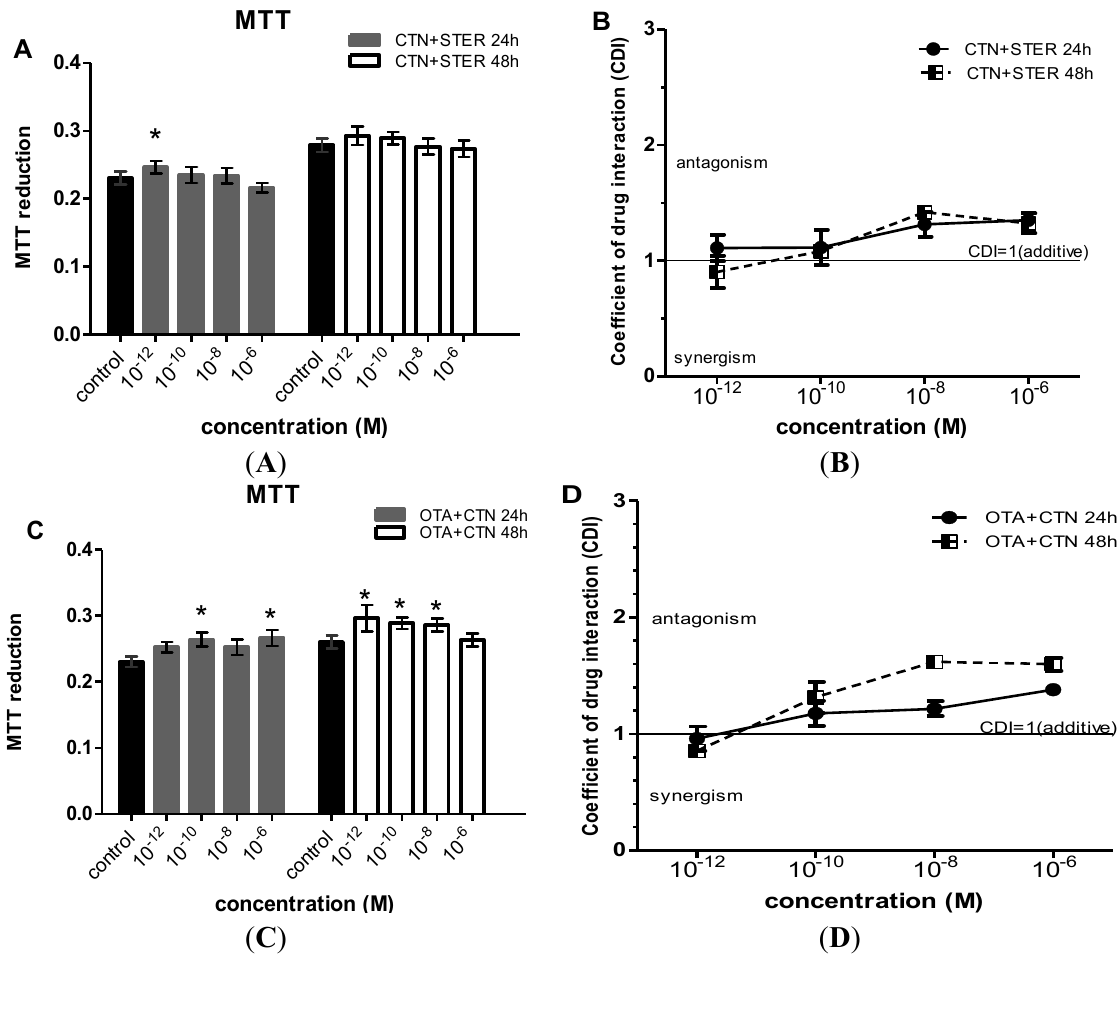
Figure. 2. Evaluation of MTT activity in Hep3B cells after co-administration of ( A ) CTN and STER ( C ) OTA and CTN ( E ) STER and OTΑ for 24 and 48h; Bars represent mean values of every concentration at each time point, which was evaluated at three individual experiments, performing measurements at a number of 8-plicates each time (8-plicates, n = 3). Error bars give the standard error (SE) between the replicates (n = 3). The asterisks represent statistically significant differences over the respective vehicle-receiving cells (control) (* p < 0.01). CDI values (CDI = 1 CDI<1 and CDI>1, shows additive, synergic and antagonistic action respectively) after co-administration of ( B ) CTN and STER ( D ) CTN and OTA ( F ) OTA and STER. Again error bars give the standard error (SE) between the replicates (n =